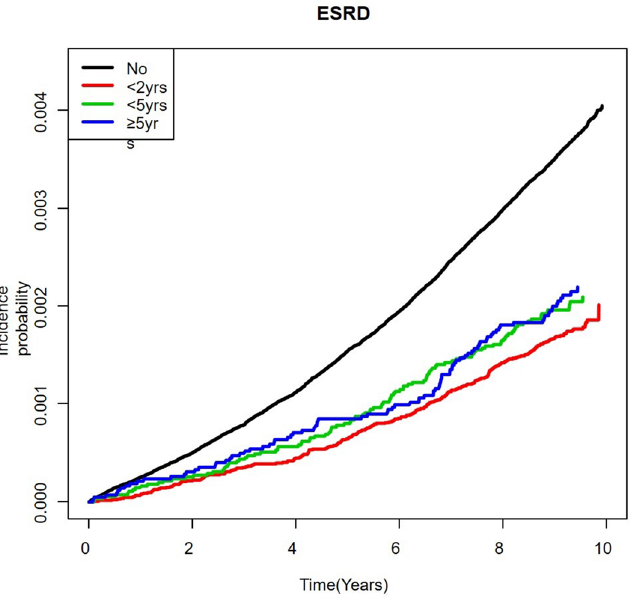
Figure 1. The Kaplan–Meier curves for development of ESRD according to the duration of